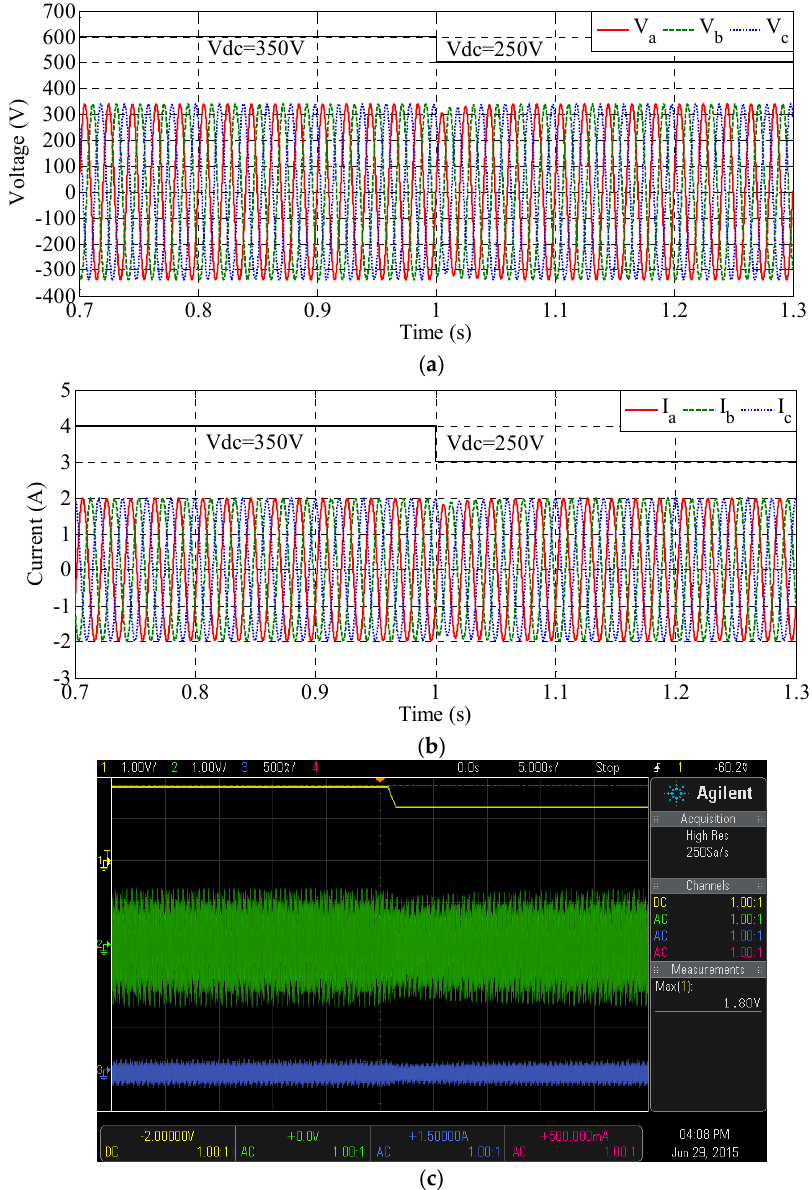
Figure 28. Waveforms with V dc decreasing from 250 V to 350 V with RL load. ( a ) Simulation voltage waveforms; ( b ) simulation current waveforms; and ( c ) experimental voltage and current waveforms (Ch. 1, Ch. 2, and Ch. 3 for V dc , V a , and I a ,